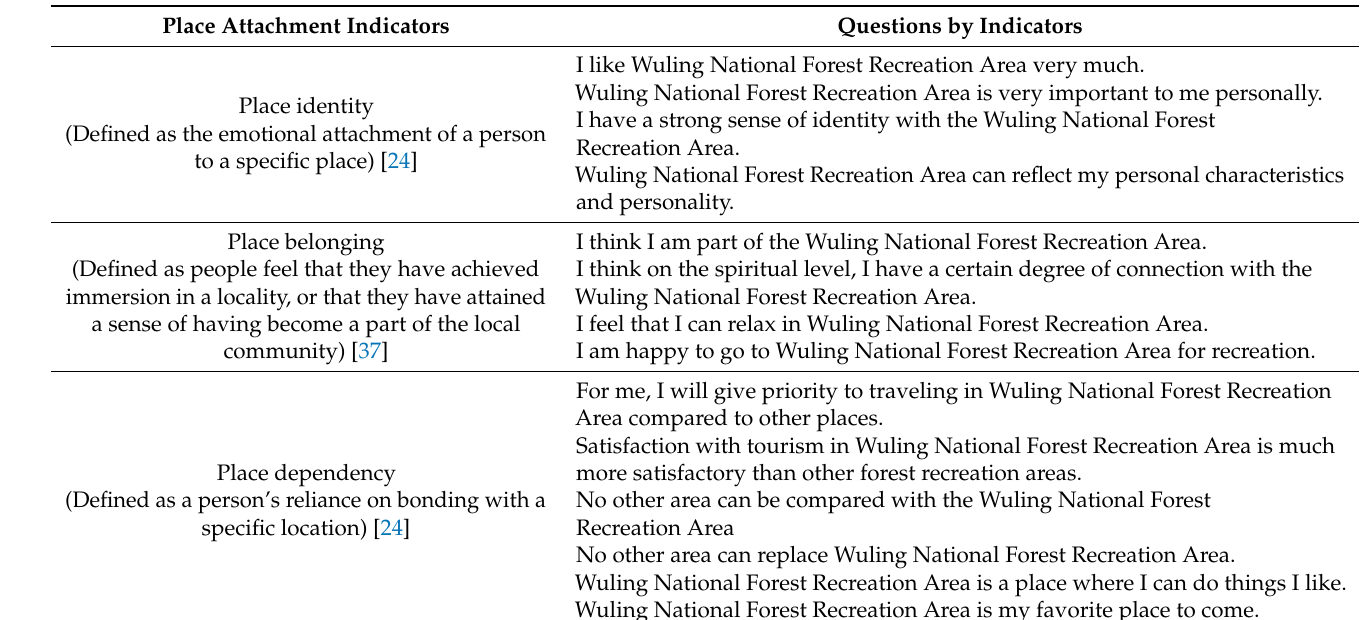
Table 1. Indicators by category for assessing place